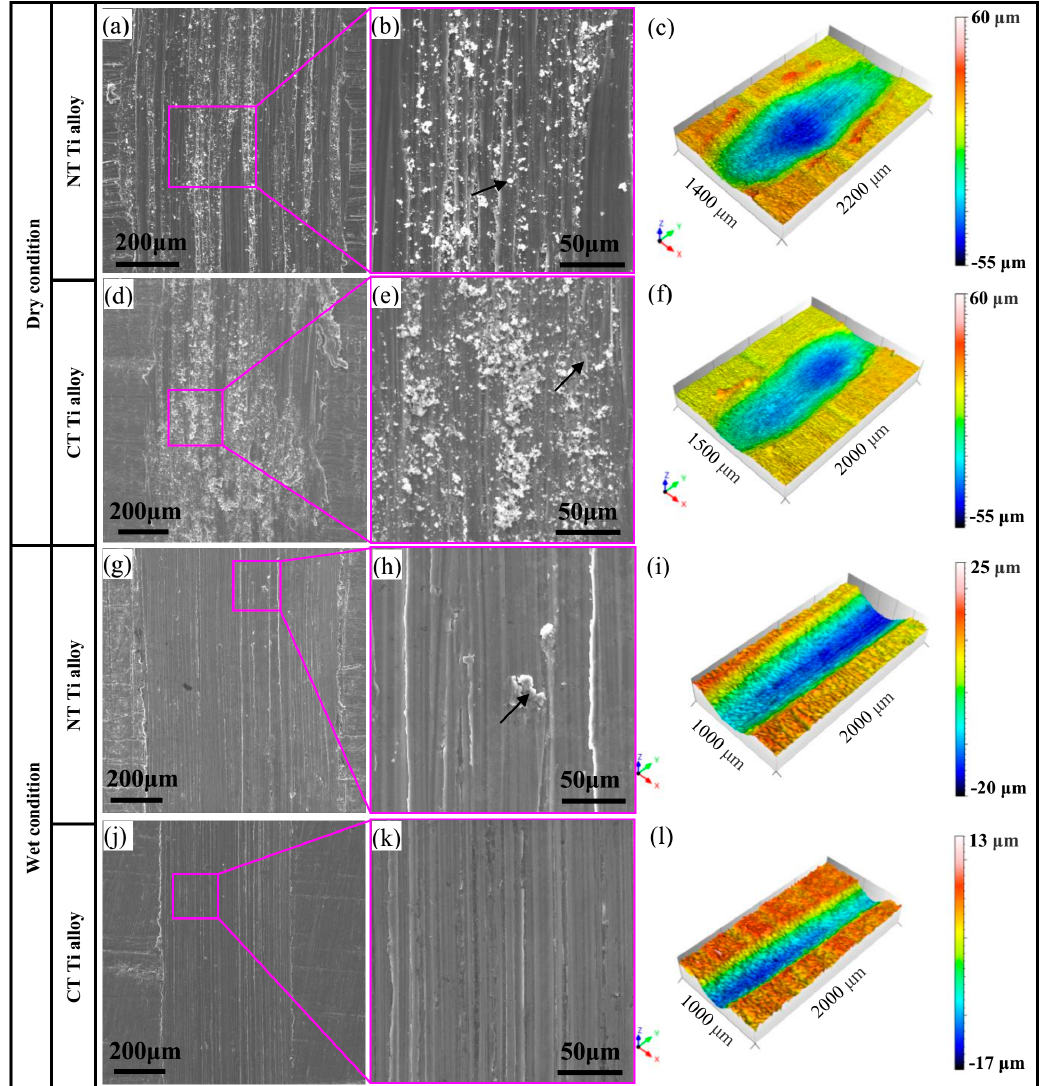
Figure 6. The wear morphologies of Ti-6Al-4V alloy before and after cryogenic treatment under dry / wet condition: ( a – c ) the SEM morphologies and the 3D morphology of NT Ti alloy under dry conditions; ( d – f ) the SEM morphologies and the 3D morphology of CT Ti alloy under dry conditions; ( g – i ) the SEM morphologies and the 3D morphology of NT Ti alloy under wet conditions; and ( j – l ) the SEM morphologies and the 3D morphology of CT Ti alloy under wet conditions.